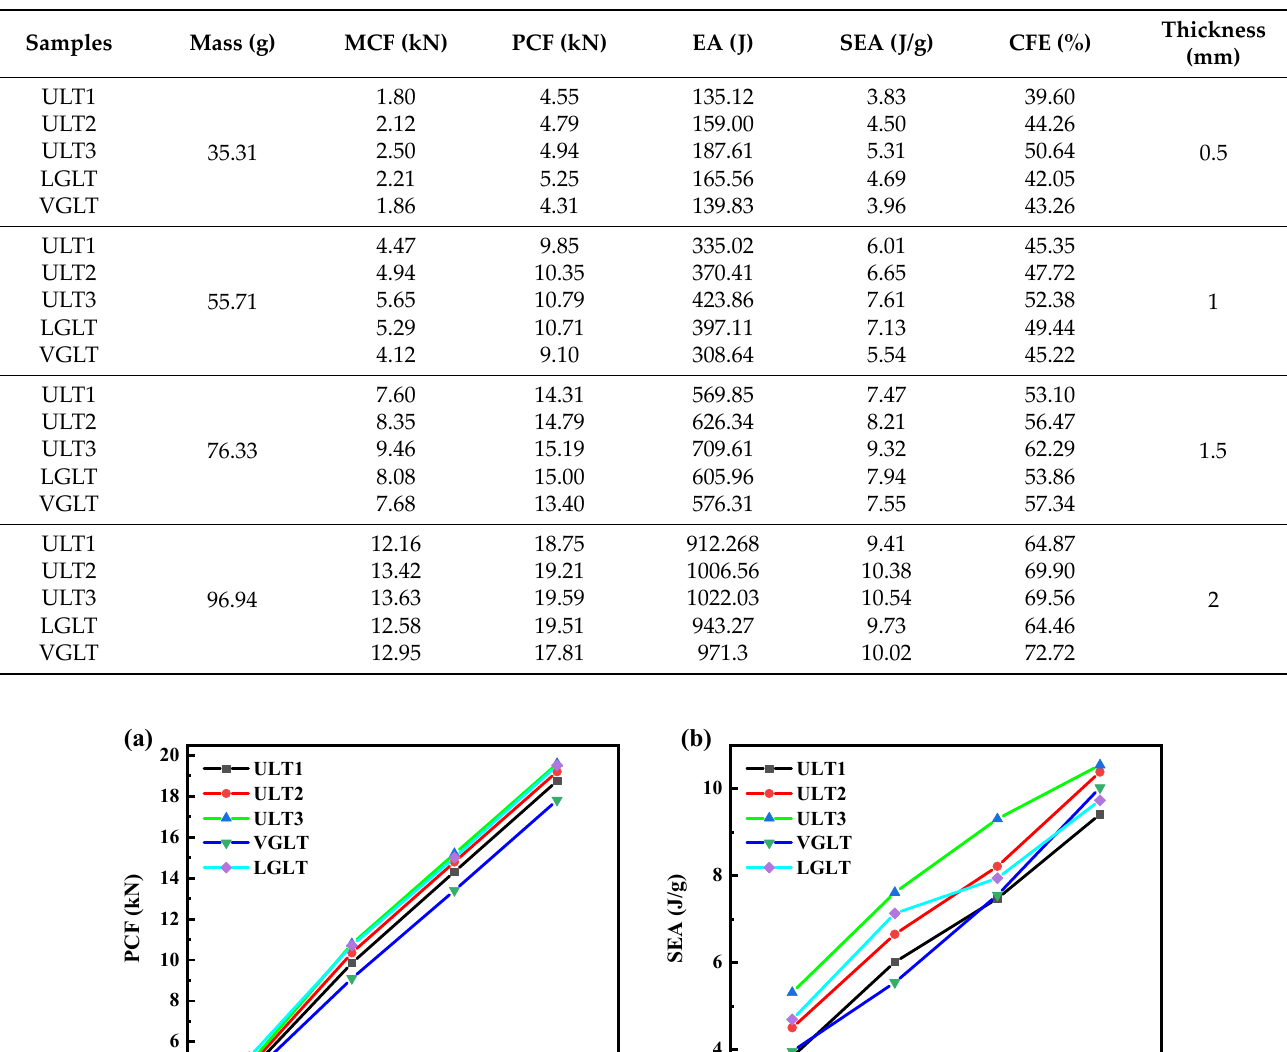
Table 5. Energy absorption parameters with different wall thickness models.